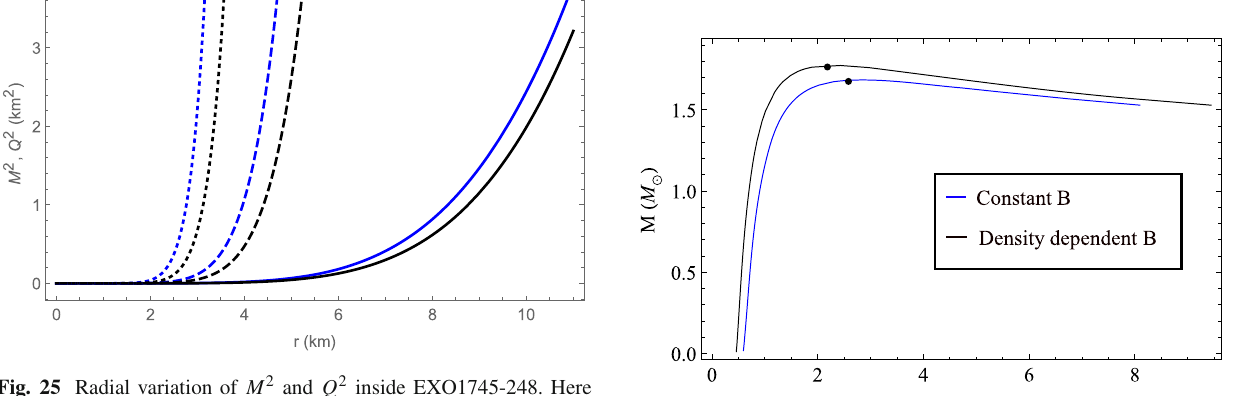
Fig. 25 Radial variation of M 2 and Q 2 inside EXO1745-248. Here blue and black curves correspond to plots of M 2 and Q 2 respectively. Solid, dashed and dotted curves correspond to D = 4, D = 5 and D = 6 respectively. To obtain these plots we have considered pressure isotropy condition and set γ = 0 . 4